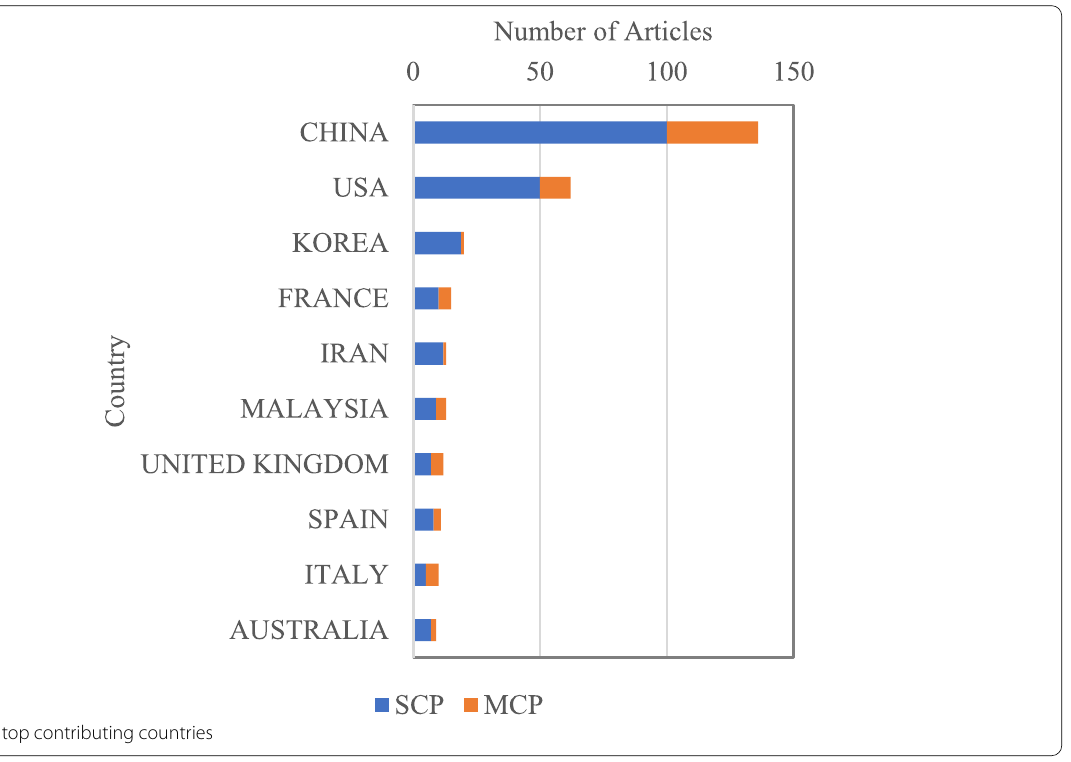
Fig. 21 Hybrid, top contributing countries